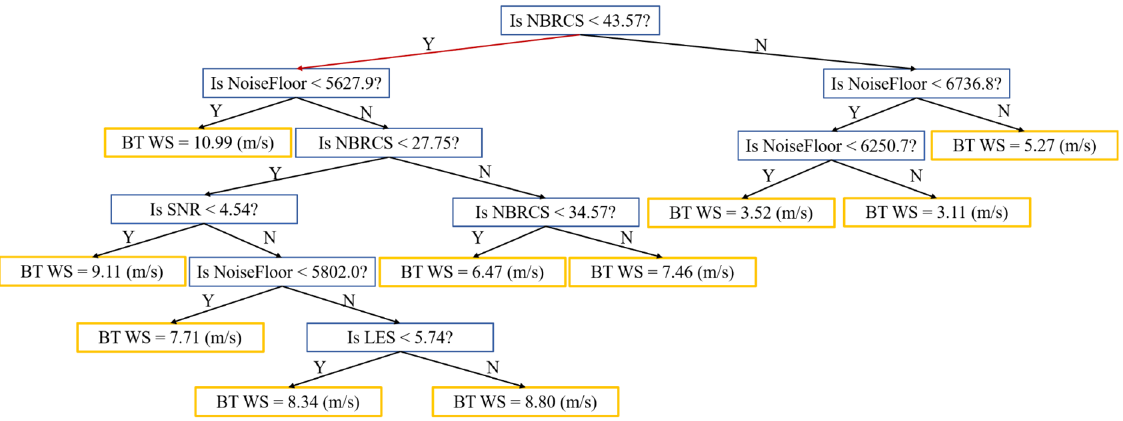
Figure 1. An example of a BT model structure.